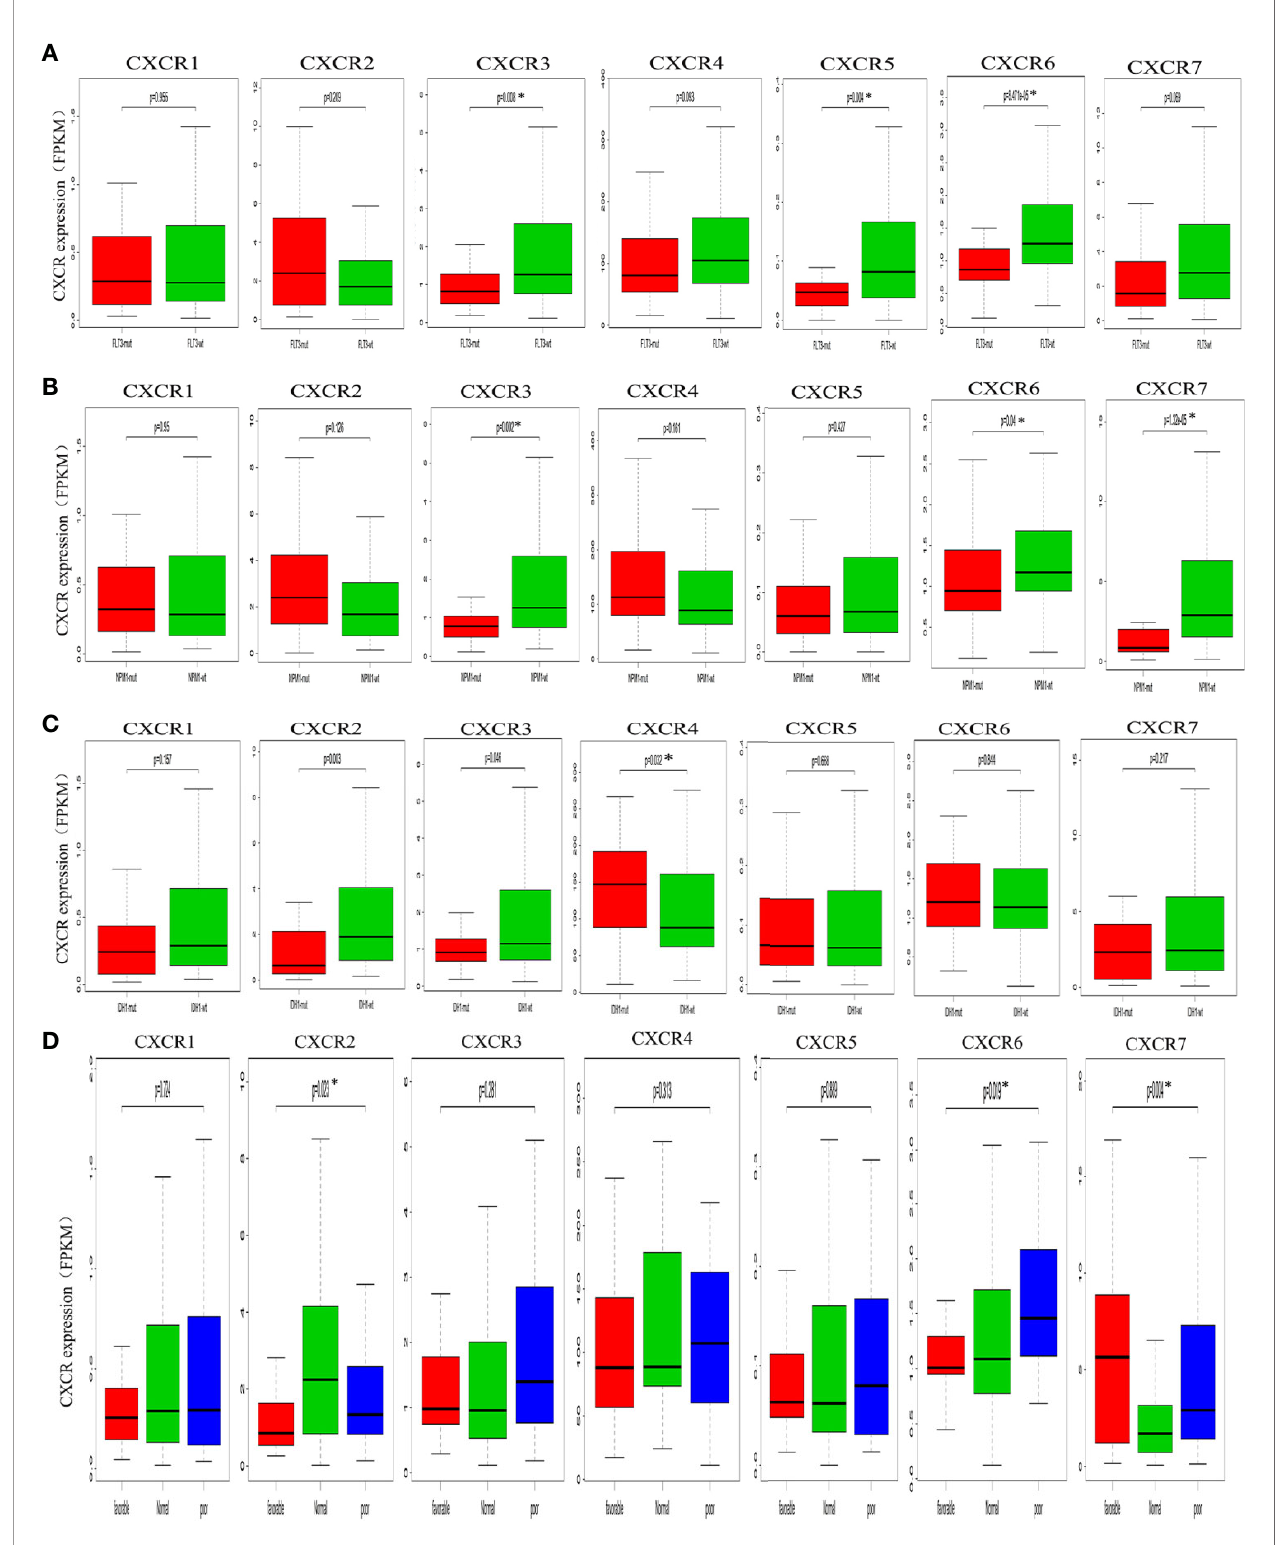
FIGURE 3 | Analysis of prognostic gene expressions between the mutant group and the wild-type group. (A) FLT3 mutation. (B) NPM1 mutation. (C) IDH1 mutation. (D) cytogenetic